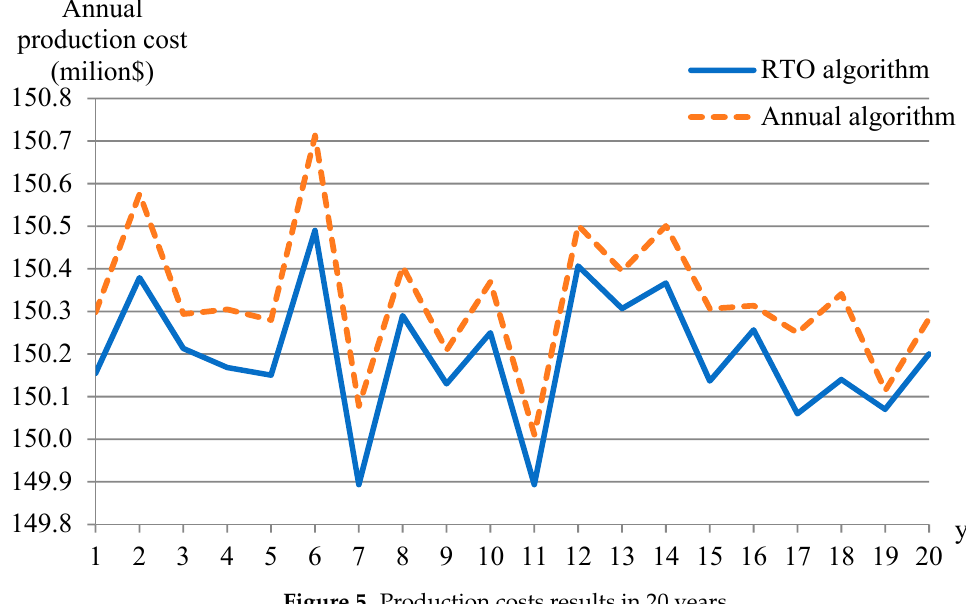
Figure 5. Production costs results in 20 years.